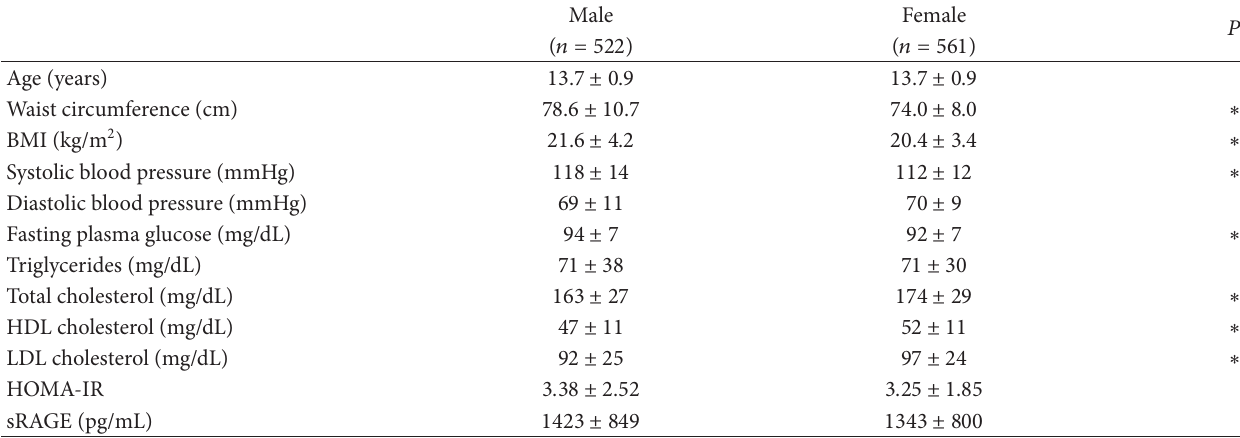
Table 1: Clinical and anthropometric parameters of participants by